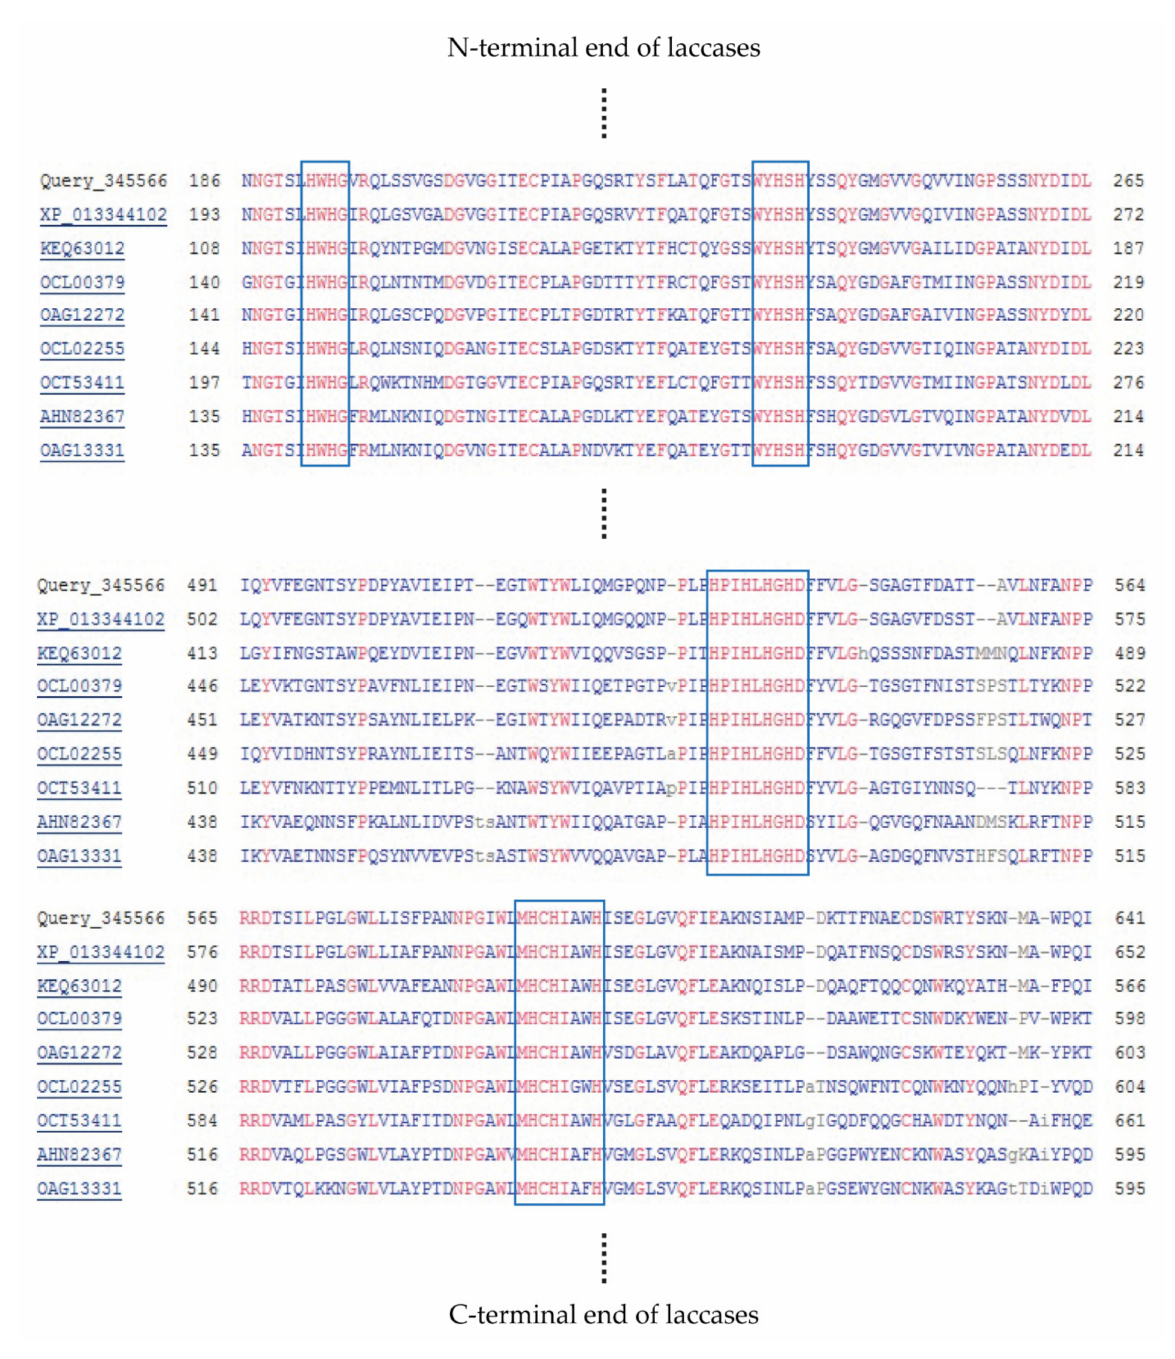
Figure 1. Multiple sequence alingment of laccase KbLcc1 and other laccase sequences from Ascomycetes using Constraint- based Multiple Alignment Tool (COBALT, https://www.ncbi.nlm.nih.gov/tools/cobalt/cobalt.cgi, accessed on 15 July 2021); strong conservative copper-binding amino acids are indicated by blue